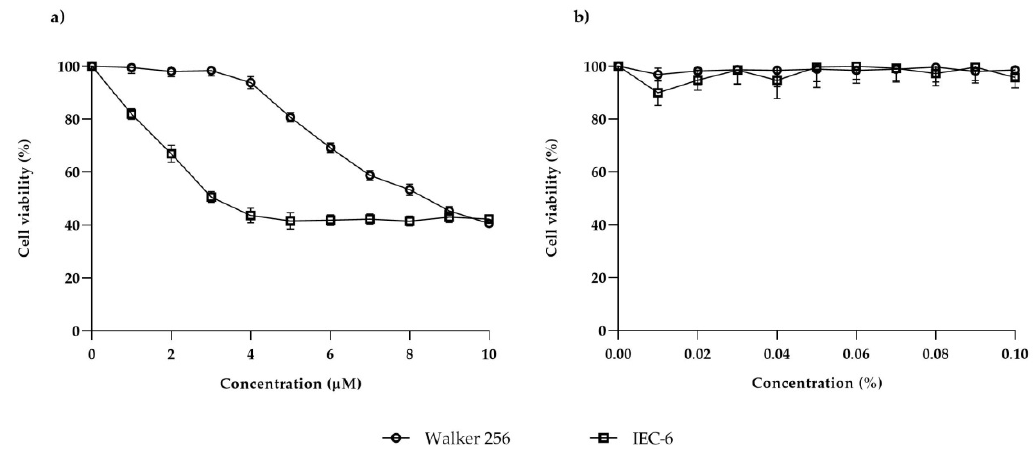
Figure 1. The e ff ect of ( a ) lapatinib and ( b ) dimethyl sulfoxide (DMSO) treatment on Walker Figure 1. The effect of ( a ) lapatinib and ( b ) dimethyl sulfoxide (DMSO) treatment on Walker 256 and 256 and IEC-6 cells as assessed by XTT (2,3- bis -(2-methoxy-4-nitro-5-sulfophenyl)-2H-tetrazolium-5 IEC-6 cells as assessed by XTT -carboxanilide solution) assay ( n = 4). Data presented as mean ± (2,3- bis -(2-methoxy-4-nitro-5-sulfophenyl)-2H-tetrazolium-5-carboxanilide solution) assay ( n = 4). Data presented as mean ± S.E.M.